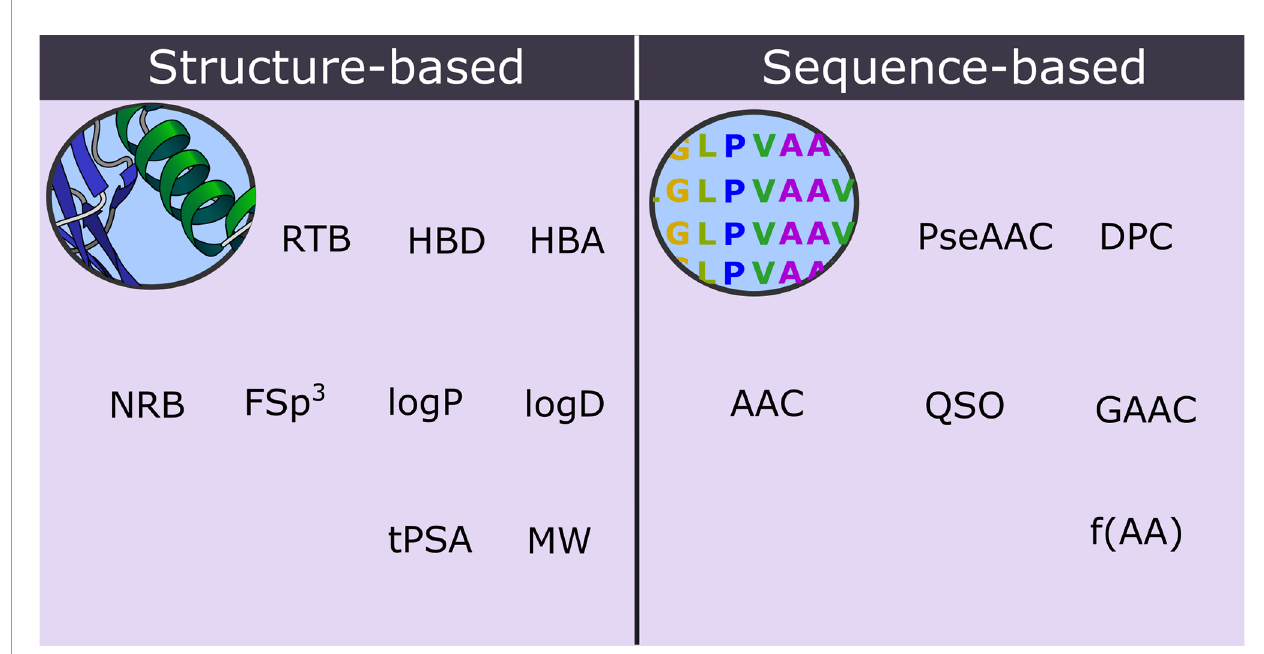
FIGURE 5 | Structure- and sequence-based molecular descriptors that are applied in the prediction of biomembrane penetrating